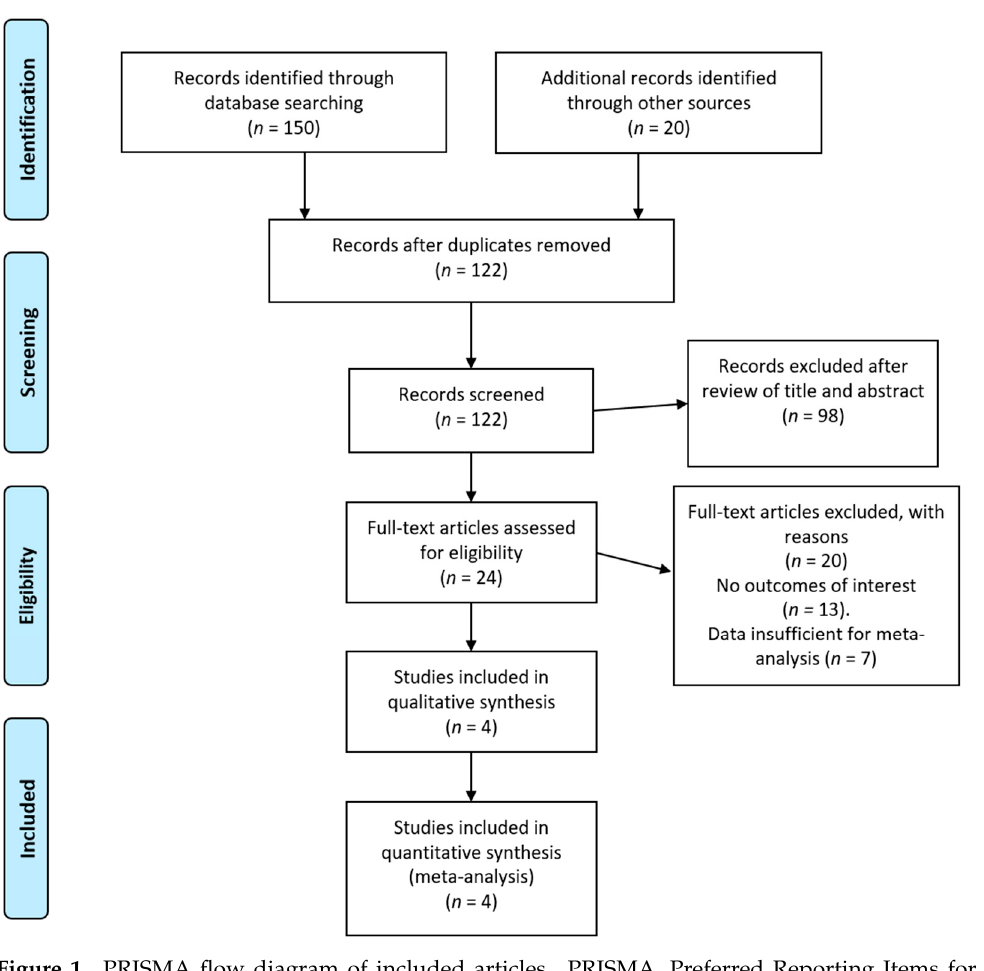
Figure 1. PRISMA flow diagram of included articles. PRISMA, Preferred Reporting Items for Systematic Reviews and Meta-Analyses.